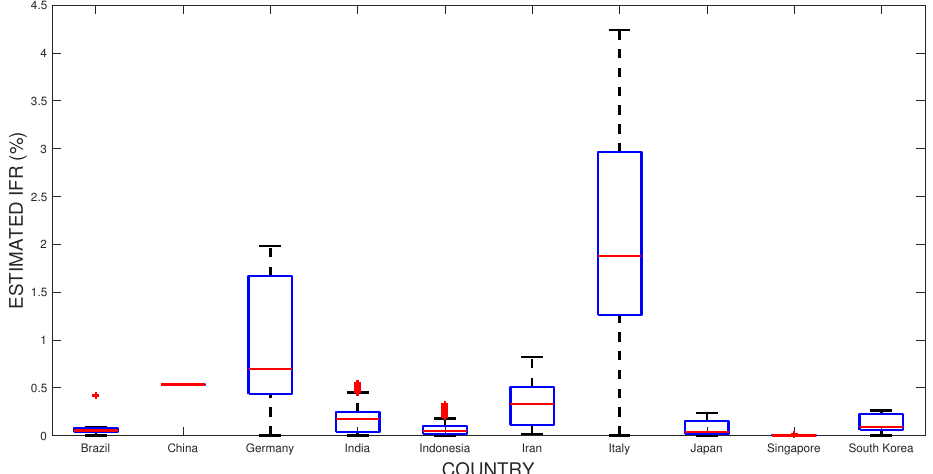
Figure 10. Estimated IFR for the ten observed countries. The blue boxes represents the range from the lower to upper quartiles, with the median (red line) was chosen to represent the single point estimated IFR . The black add signs depicts its maximum and minimum values of the estimated